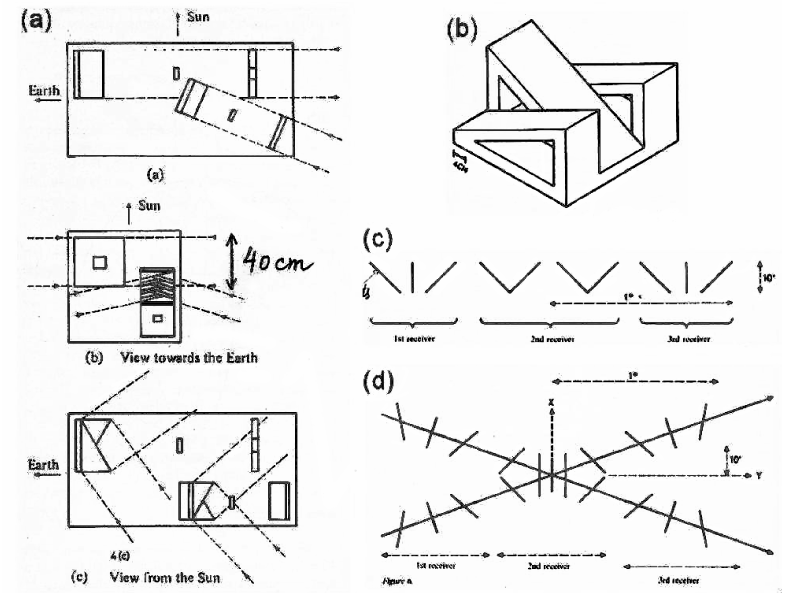
Fig. 2. (a): Two telescopes as proposed by Lacroute. By rotation about a spin axis pointing in the direction to the Sun the telescopes will continuously scan the sky with slits as in (c) and (d). (b): A beam combiner placed in front of the telescope aperture will combine the beams from two fields on the sky separated by an angle of 90 degrees. The angle will be very stable as defined by the rigid material. (c) and (d): The stars will cross the slits and be measured by six photomultipliers. The upper system is used in the larger telescope of (a), the lower one in the smaller telescope. Since the latter telescope is scanning a small circle on the sky the stars from the two fields move in different directions on the focal plane. Source: Lacroute